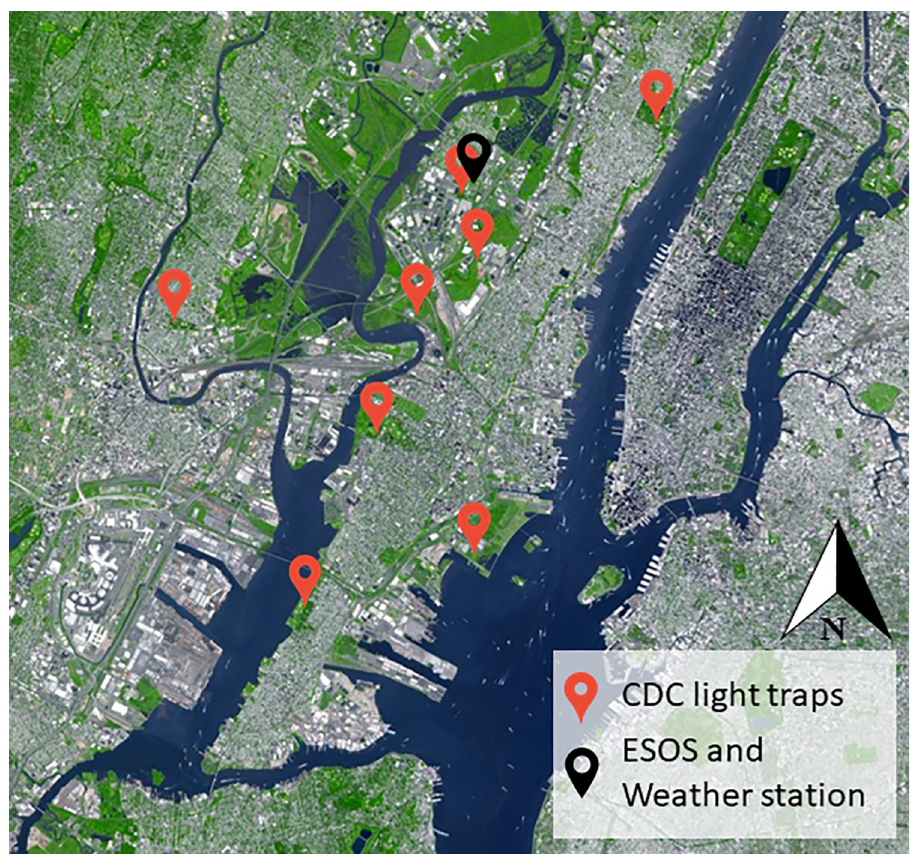
Fig 1. Aerial view of the experiment location (40˚47’09.8"N 74˚03’28.1"W) and its surroundings, the US Northeast megalopolis (Manhattan Island top right corner). The ESOS system and the co-located weather station are symbolized by a black marker. The position of the CDC light traps used for comparison are indicated by a red marker. Image courtesy of NASA’s Earth Observatory, NASA/GSFC/MITI/ERSDAC/JAROS, and U.S./Japan ASTER Science